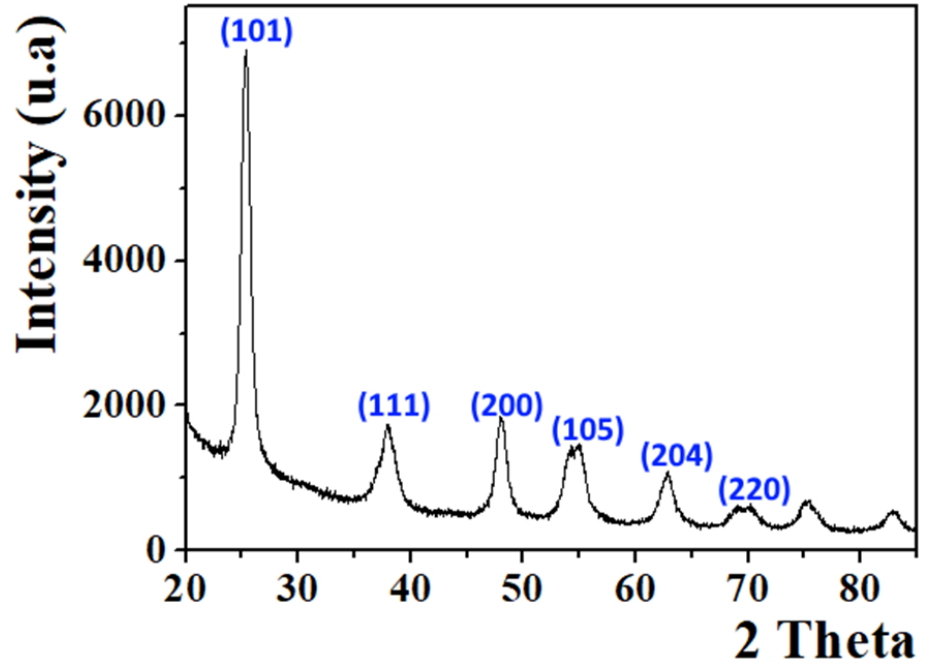
Figure 2. XRD pattern of TiO 2 nanoparticles.